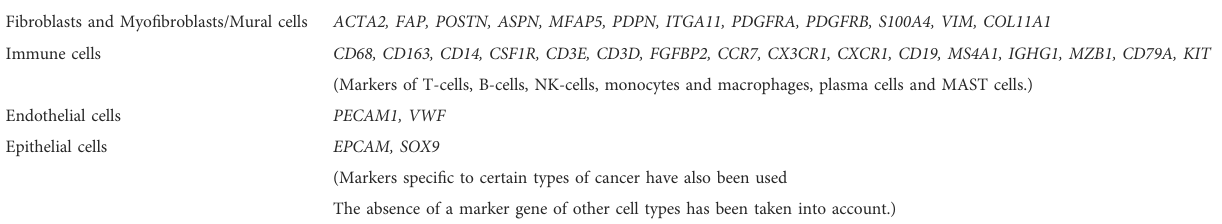
TABLE 2 Marker genes used to identify different types of